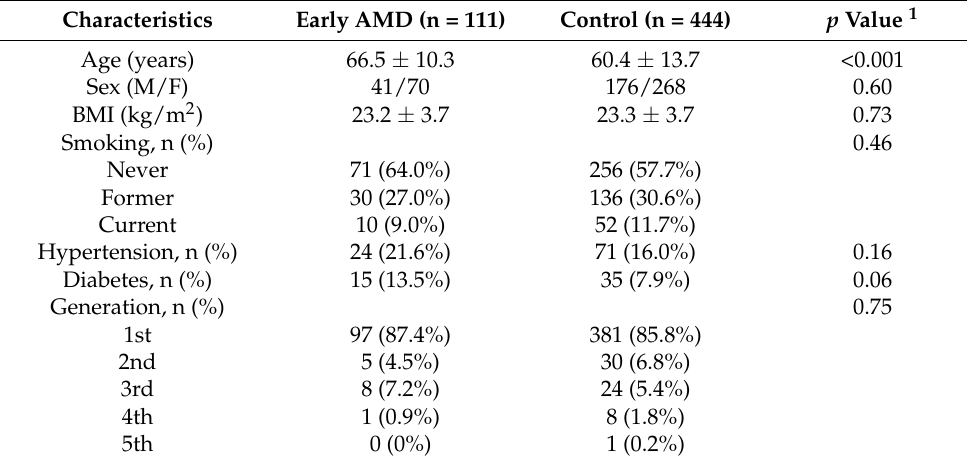
Table 1. Clinical characteristics of study participants.